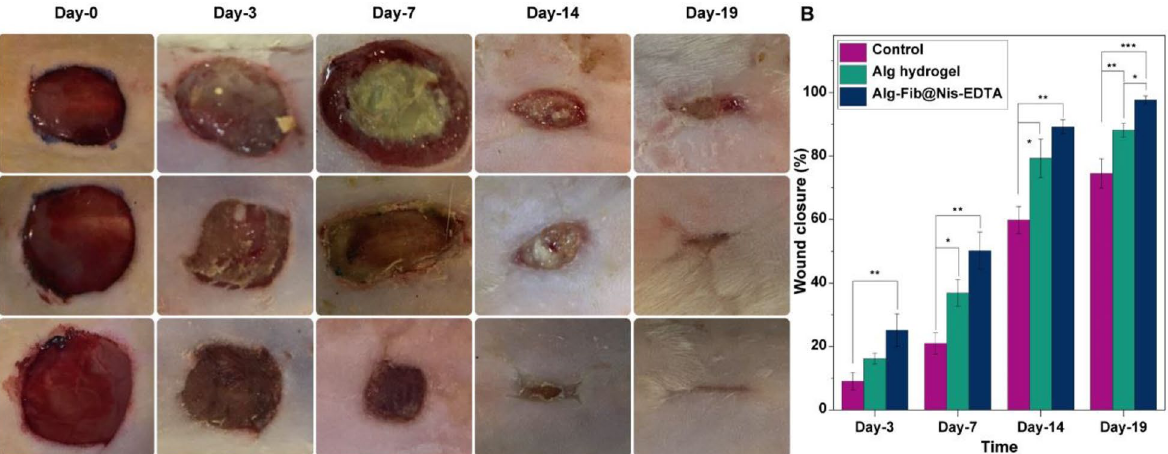
Figure 7. In vivo wound healing results. ( A ) Macroscopic appearances of the wounds treated 1st, 3rd, 7th, 14th and 19th days post-wounding. ( B ) Histogram comparing the wound closure on 1st, 3rd, 7th, 14th, and 19th days post-wounding. Values represent the mean ± SD, n = 3, * p < 0 .05, ** p < 0 .01, and *** p < 0.001. SD: standard